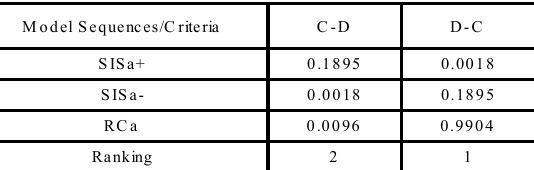
TABLE 6. POSITIVE SEPARATION, NEGATIVE SEPARATION AND RELATIVE CLOSENESS